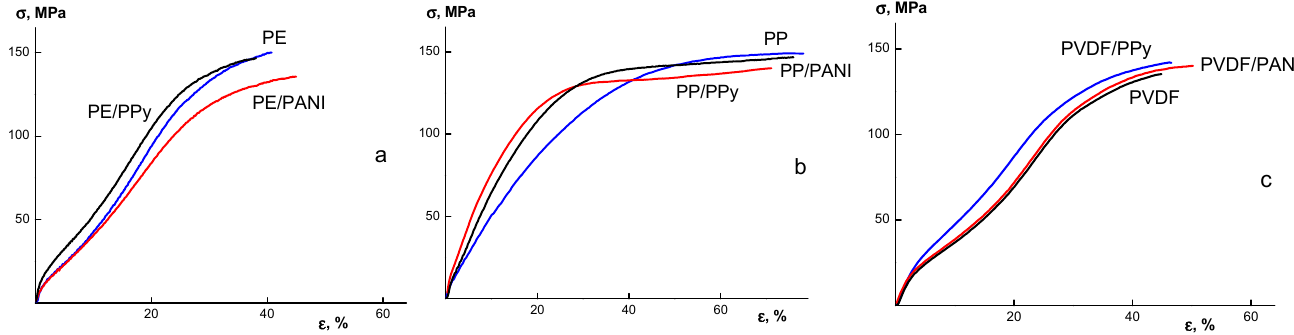
Figure 7. Stress-strain curves for the supports and the composites based on PE ( a ), PP ( b ) and PVDF ( c ) porous films. ( c ) porous films.